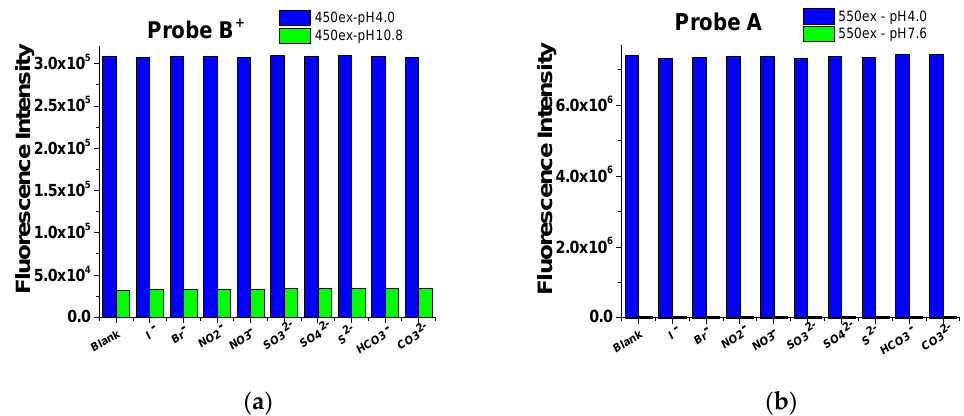
Figure 7. Fluorescence intensity of probes A and B + in the absence and presence of 50 µM different anions at pH 4.0 and 11.3 under excitation of 450 nm for probe B + ( a ) and under 550 nm excitation for probe A ( b ).